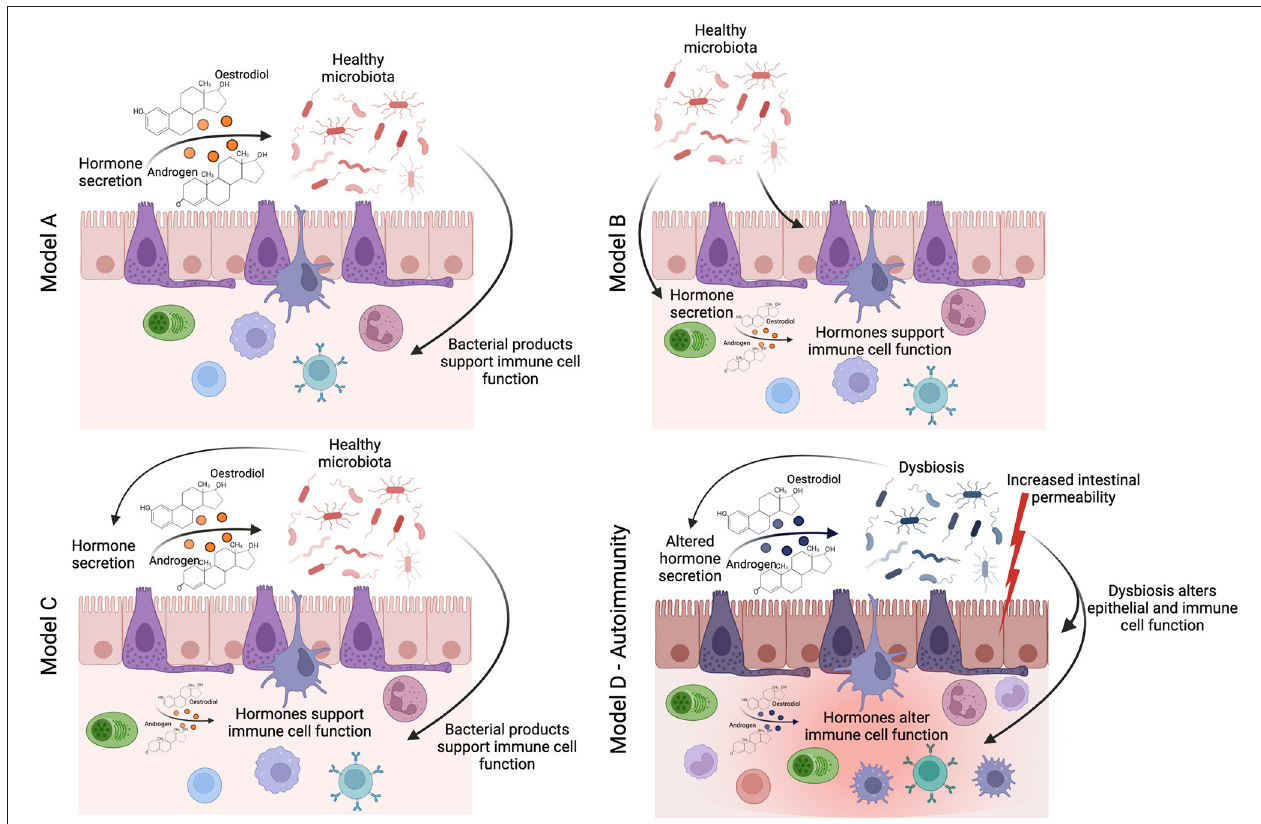
FIGURE 1 | How does sexual dimorphism in the gut-microbiota influence the immune system in health and disease? The seminal study by Yurkovetskiy et al. (6) proposes three models by which the sexual dimoprhism in the gut-microbiota may influence immune system function. In linear model A, sex-hormones regulate the identity of gut-microbes (either through immune or metabolic mechanisms), and then the gut-microbes themselves activate specific immune effector mechanisms. In linear model B, gut-microbes are regulators of sex hormone metabolism, and sex-hormones are the actual effectors on immune responses. In a two-signal model C, both microbiota and hormones could contribute in an additive fashion to influence effector mechanisms ( 6). We would like to add an additional model for autoimmune conditions (model D), where homeostasis is lost, leading to dysbiosis, increased intestinal permeability, potential changes in the regulation of sex-hormone production, and thus altered function of the immune cell compartment and chronic inflammation.